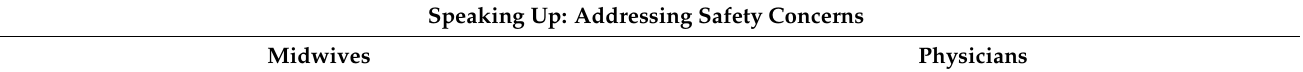
Table 4. Managing conflicts and speaking up from the different professional